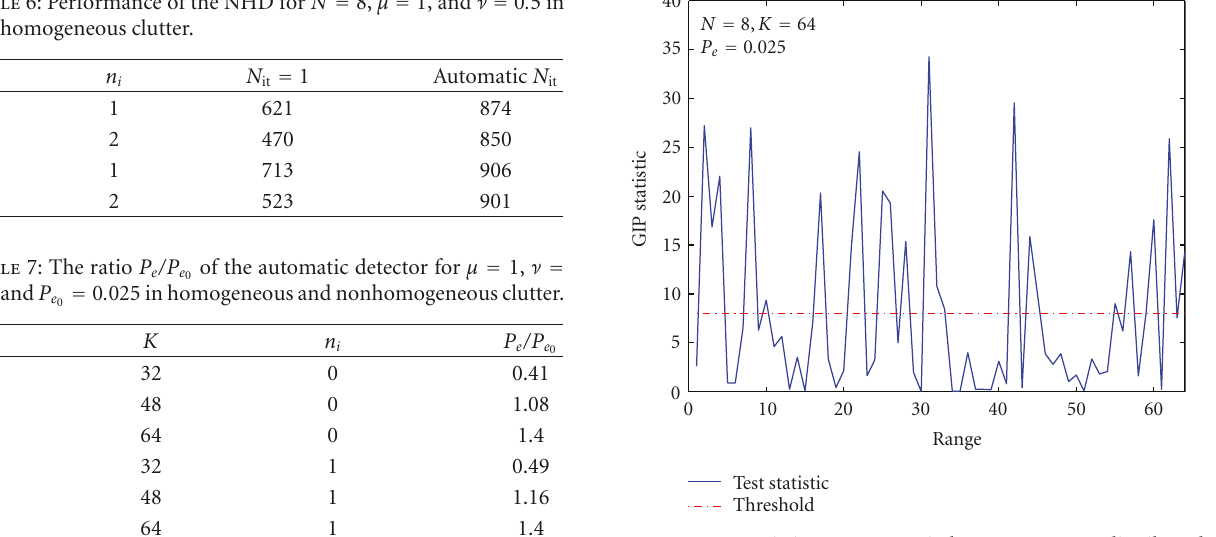
Figure 7: GIP statistic versus range in homogeneous K -distributed. ν = 0 . 5, μ = 1, N = 8, K = 64, and P